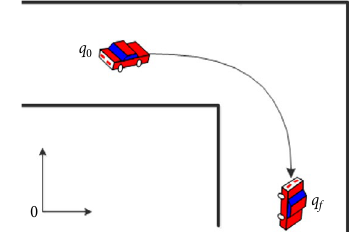
Fig. 4. The right-angle turn maneuver